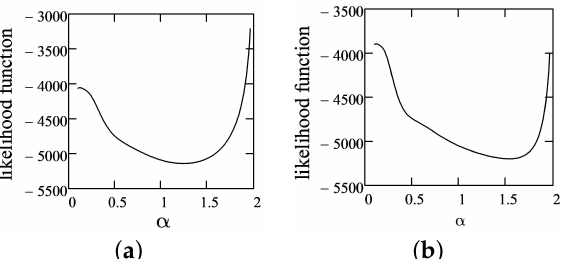
Figure 2. LLF dependence on α : ( a ) at the first iteration; and ( b ) at the last iteration for stock data.